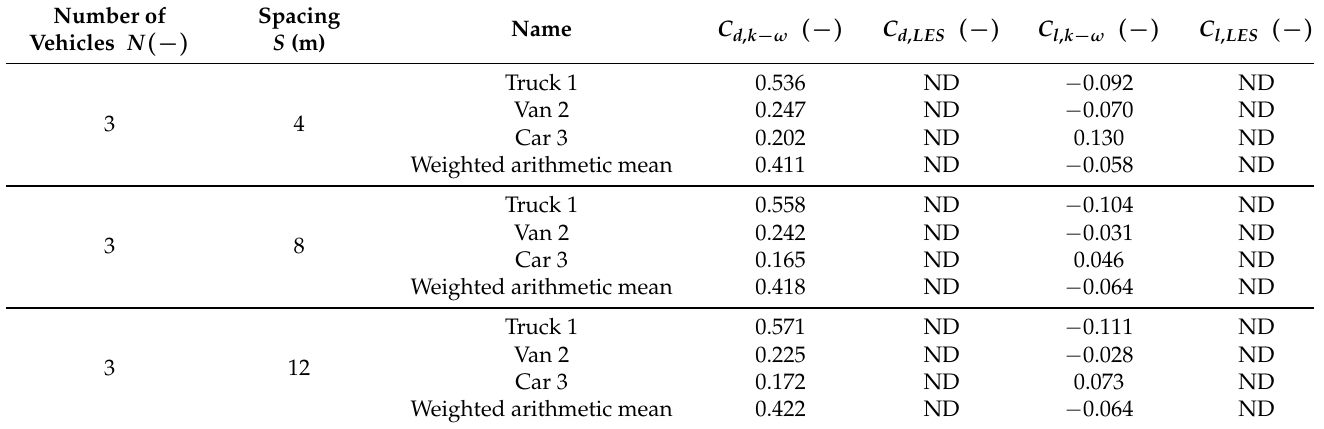
Table A5. Drag coefficient and lift coefficient of vehicles in heterogeneous columns (Truck–Van–Car). Number